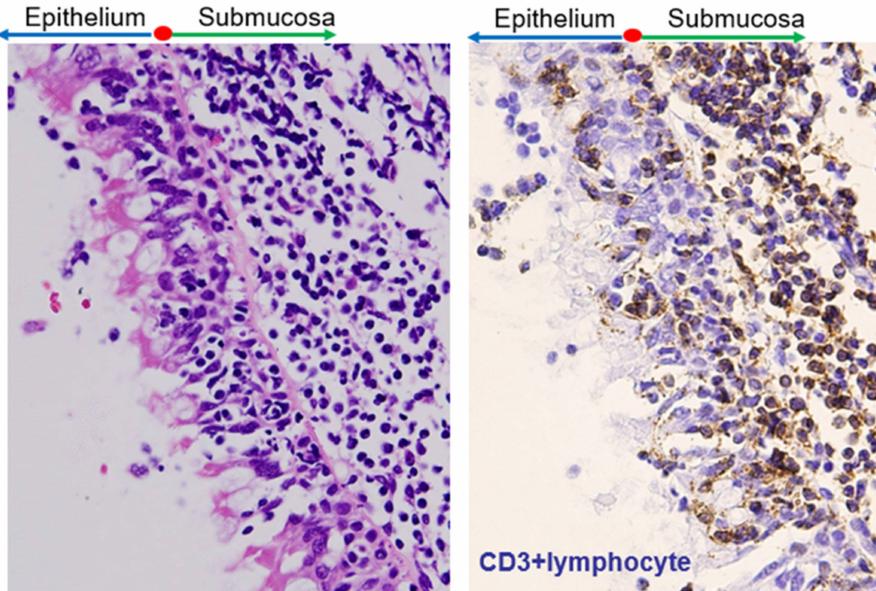
Figure 8. Surface of the epipharynx. There is an abundance of lymphocytes in the submucosal area (left, hematoxylin and eosin staining, original magnification × 100). Many lymphocytes are located within ciliated epithelial cells (right, indirect immunoperoxidase staining with anti-CD3 antibody, original magnification ×